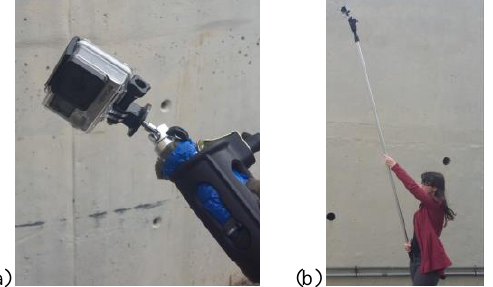
Figure 1. GoPro camera fixed in a small tripod at the end of the rod (a); the rod held tilted, by an operator (b).